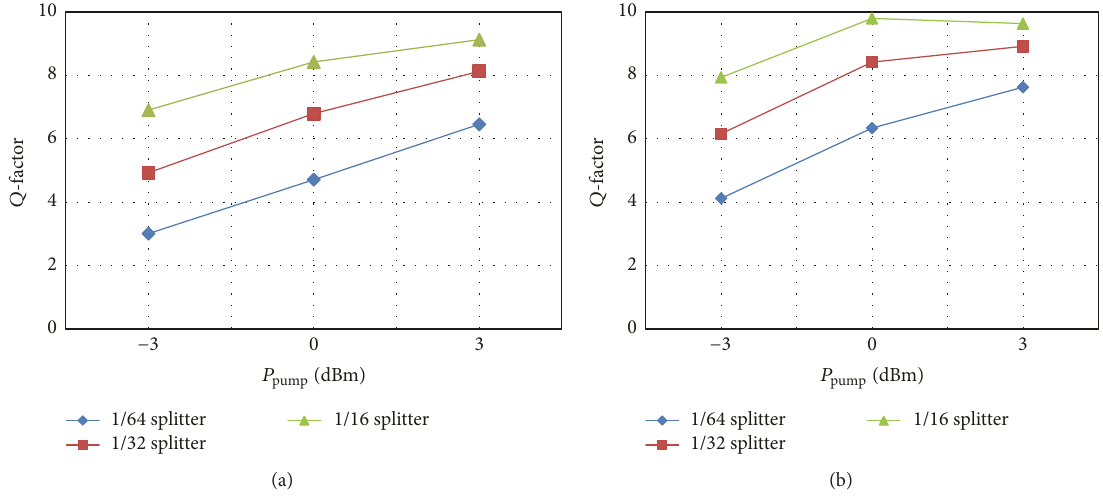
Figure 4: Impact of optical power splitter: (a) 1554 nm wavelength and (b) 1558 nm